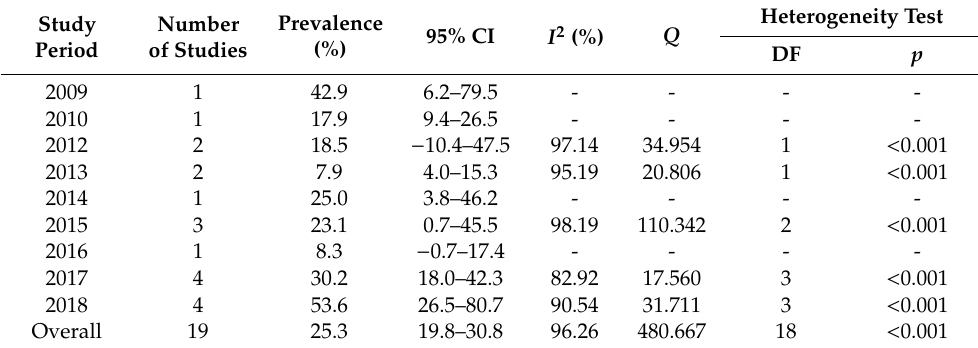
Table 6. Subgroup analysis for comparison of prevalence of VRE across study periods.